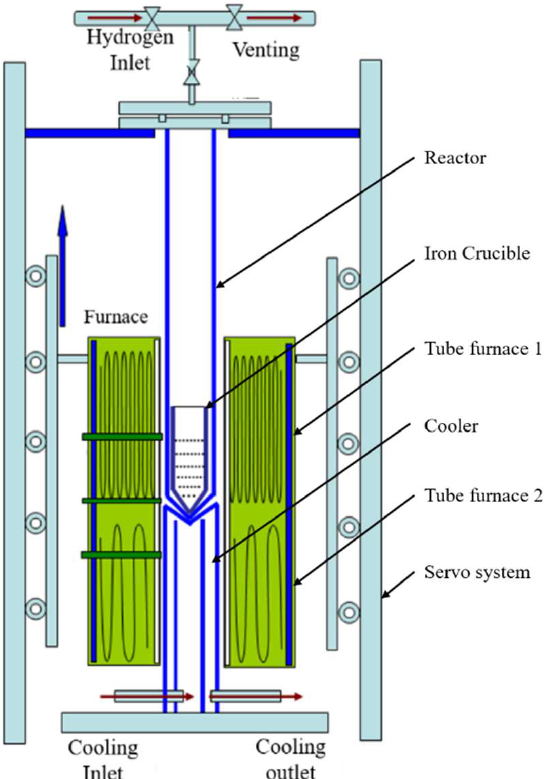
Figure 1. Schematic diagram of LiH single crystal growth device.